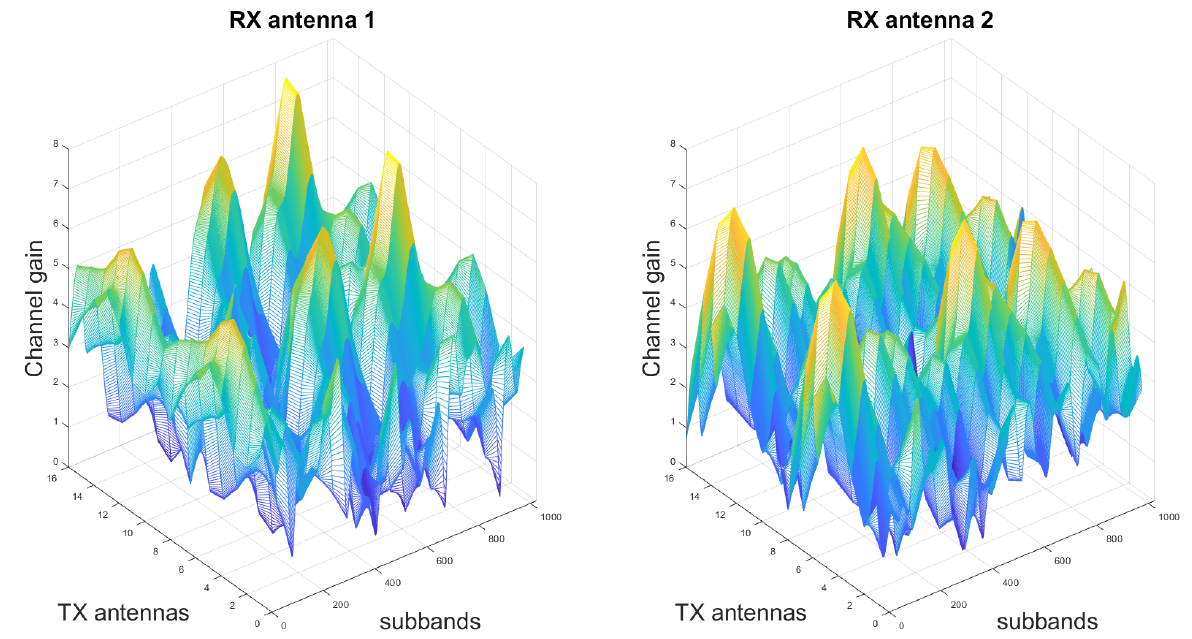
Figure 7. Channel frequency response along 1024 subbands, with 16 transmit antennas at the BS.